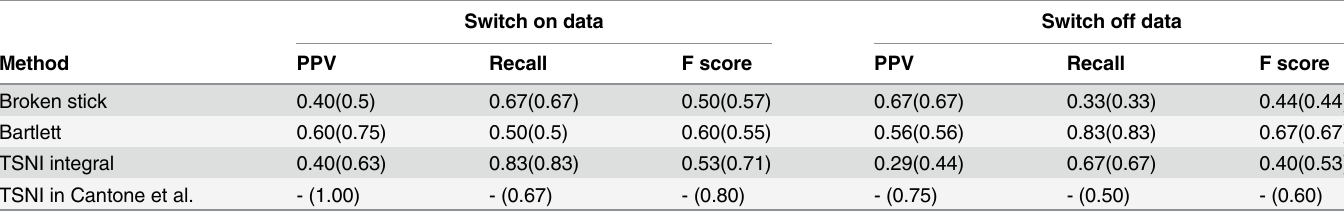
Table 5. Reconstruction of 5-node synthetic Yeast IRMA network.